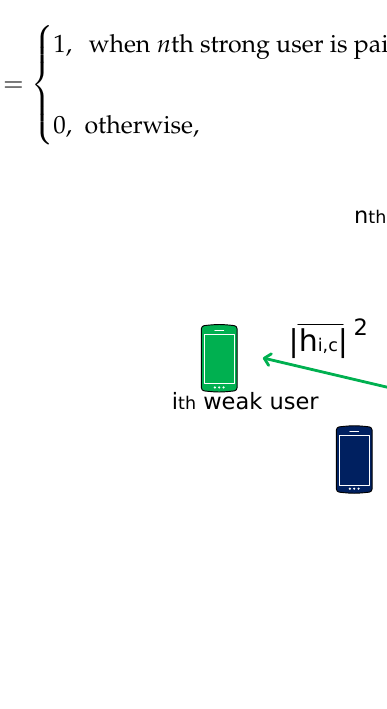
Figure 1. Considered system